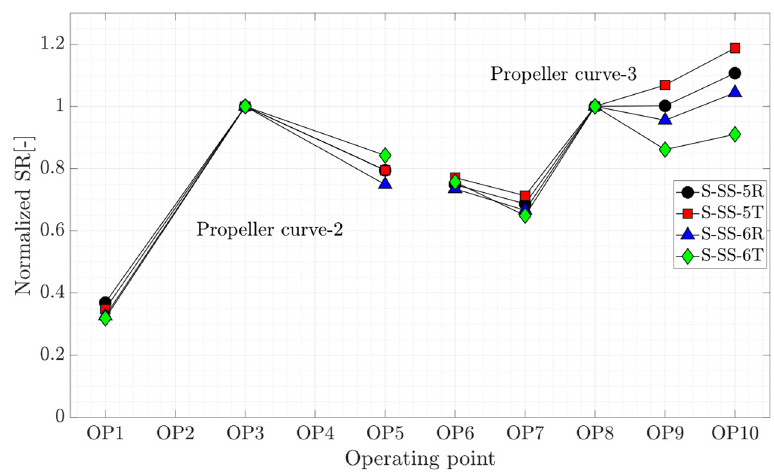
Figure 15. SR variation at OP0–OP10.